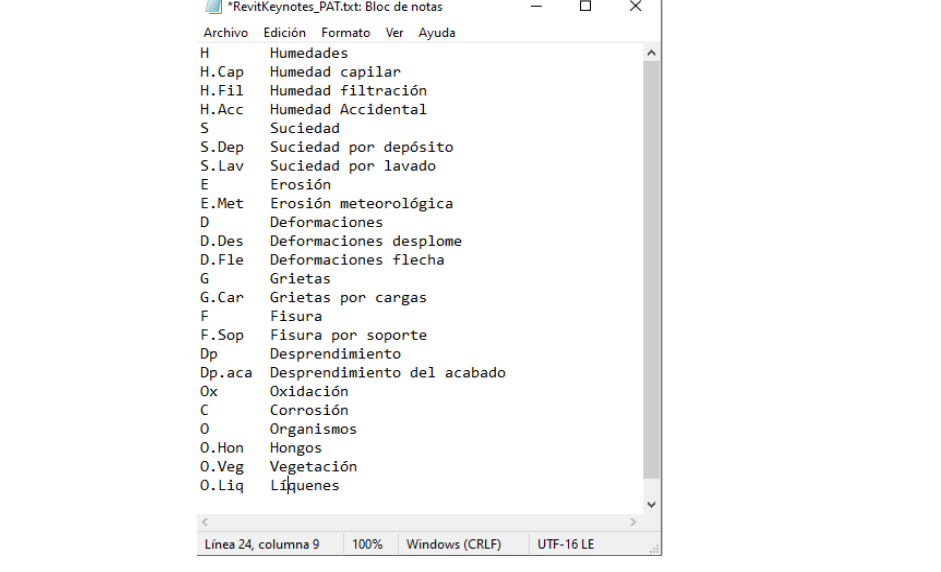
Figure 20. Screenshot of injury legend entered in Revit as keynotes.